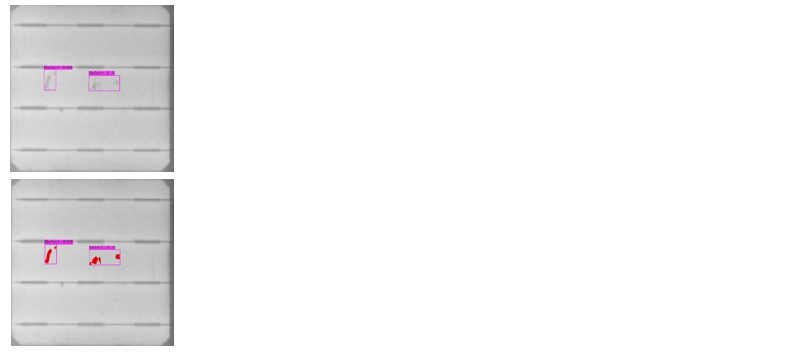
Figure 21. Snapshots of detected defect bounding boxes ( upper row ) that contain obscure defects and their color-marking results ( lower row